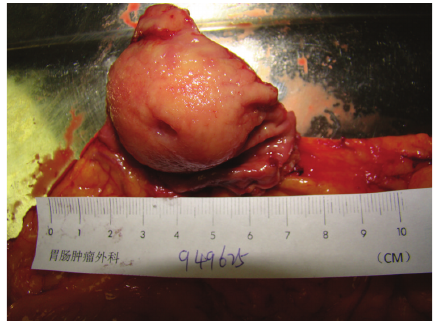
Figure 1: Gross appearance of resected specimen of one case. The gastricsubmucosalschwannomaencapsulatedwithnormalmucosa, with ulceration on the